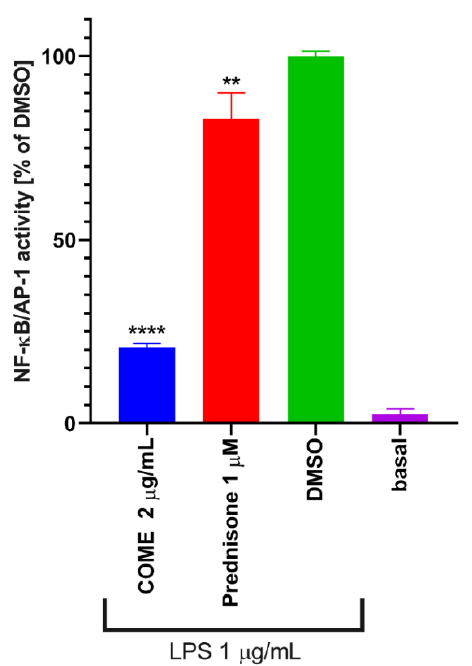
Figure 3. E ff ect of COME on the activity of NF- κ B / AP-1 in LPS-stimulated THP-1-XBlue ™ -MD2-CD14 cells. Cells were pre-treated in indicated concentrations by COME, prednisone or only solvent (DMSO) for 1 h, after that, LPS was added and NF- κ B / AP-1 activity was measured 24 h later. ** indicates statistical significance to positive control (DMSO) p < 0.01, **** indicates statistical significance to positive control (DMSO) p <